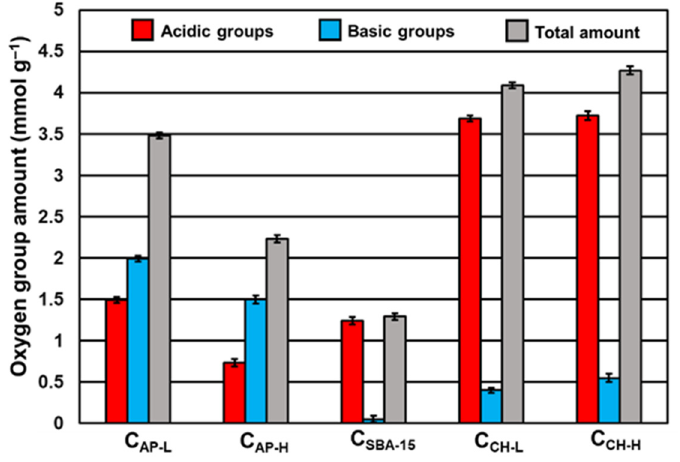
Figure 5. Amount of acidic and basic oxygen functional groups on the carbon carriers’ surface de- termined via Boehm